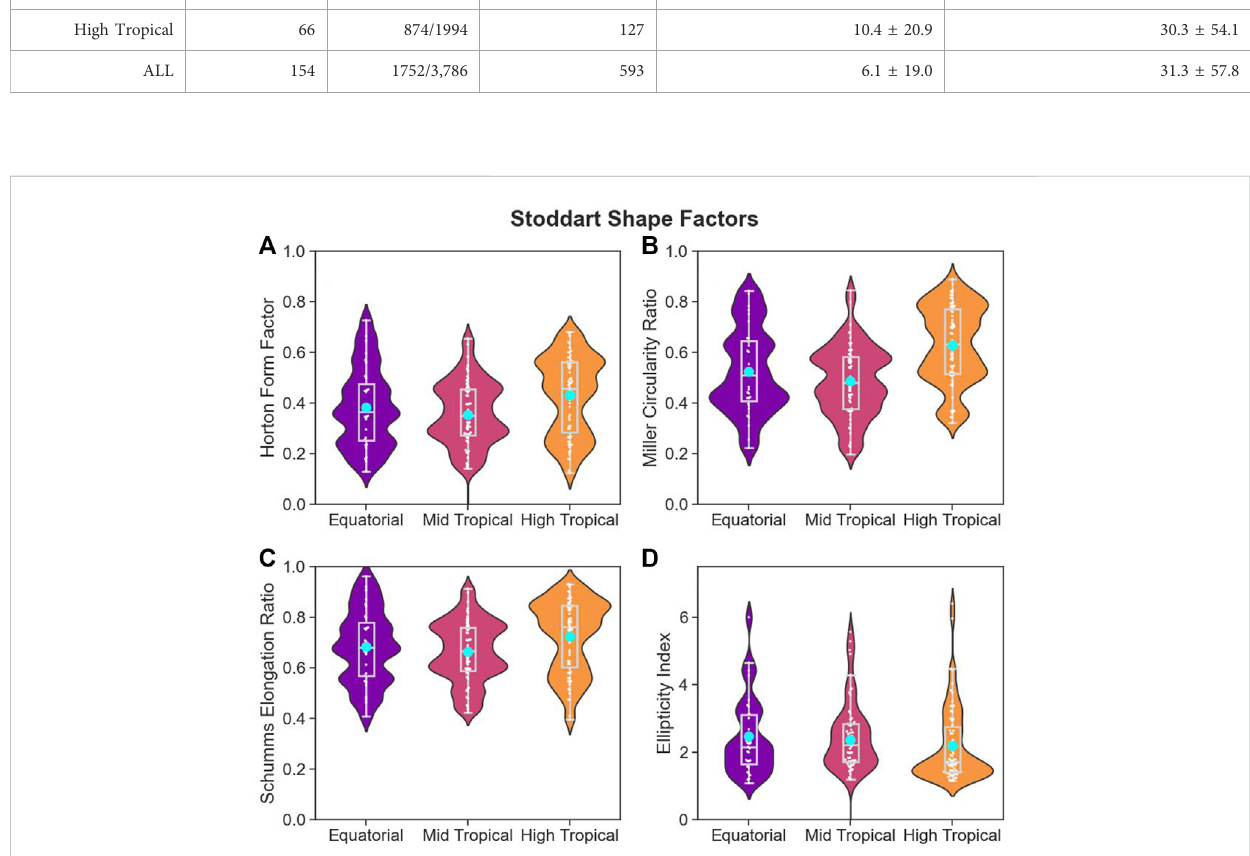
FIGURE 8 Violinplotofshapefactors usedinStoddart(1965)foratollsgrouped bylatitude,withoverlainpointsinwhite,boxplotshowingmedianandquartiles in light grey, and cyan circular marker indicating the mean of each shape factor the mean of each shape factor: (A) Horton Form Factor, (B) Miller Circularity Ratio, (C) Schumms Elongation Ratio, and (D) Ellipticity Index as speci fi ed in Supplementary Text